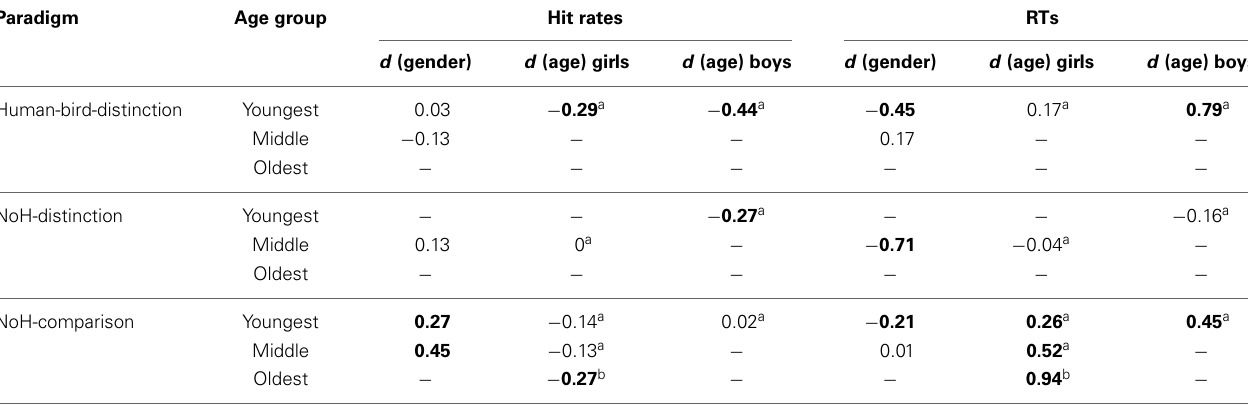
Table 3 | Effect sizes for gender and age group differences for the three different paradigms in the subsample of children not completing all paradigms ( N =